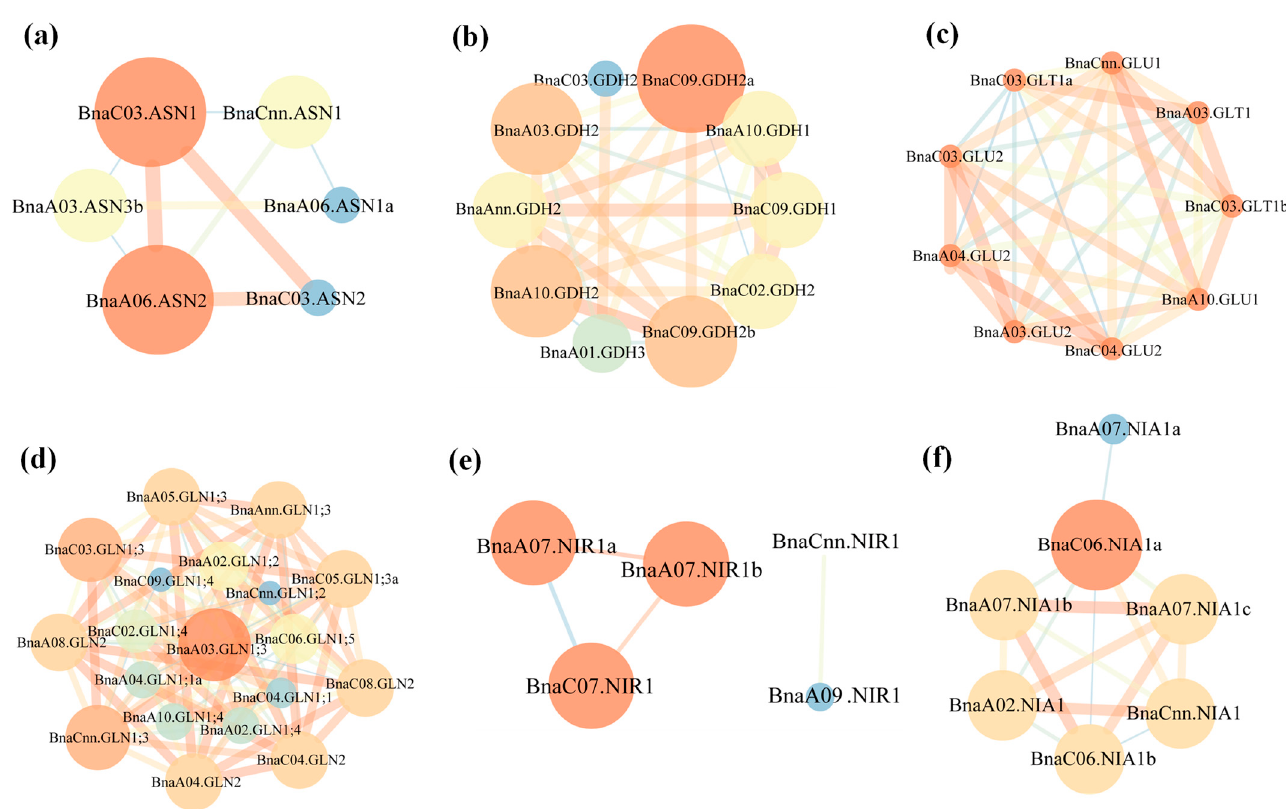
Figure 8. Coexpression networks of the genes involved in nitrogen assimilation in Brassica napus. ( a ) The AS family genes; ( b ) The GDH family genes; ( c ) The GOGAT family genes; ( d ) The GS family genes; ( e ) The NiR family genes; ( f ) The NR family genes. Each cycle node represents a gene, and the size of the node represents the power of the interrelation among the nodes by degree value. The width of the lines indicates the strength of the interactions be-tween two